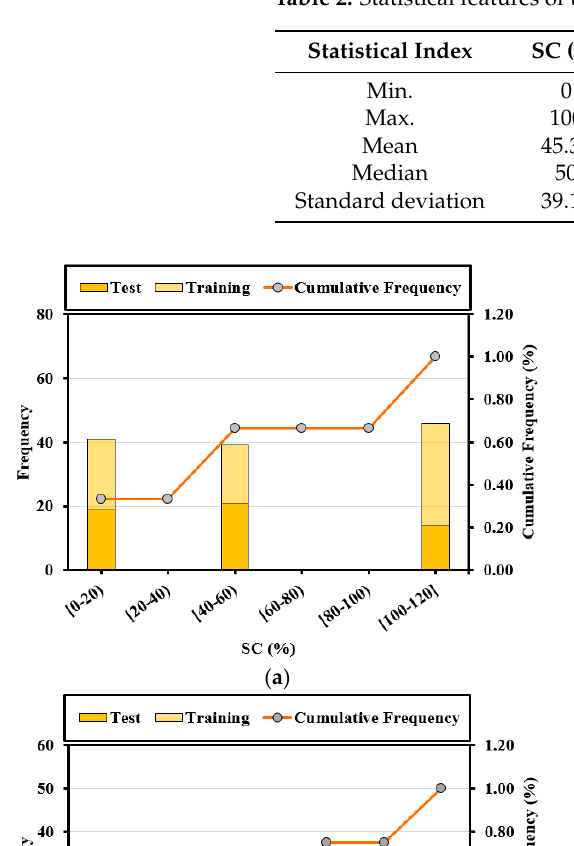
Table 2. Statistical features of testing data.